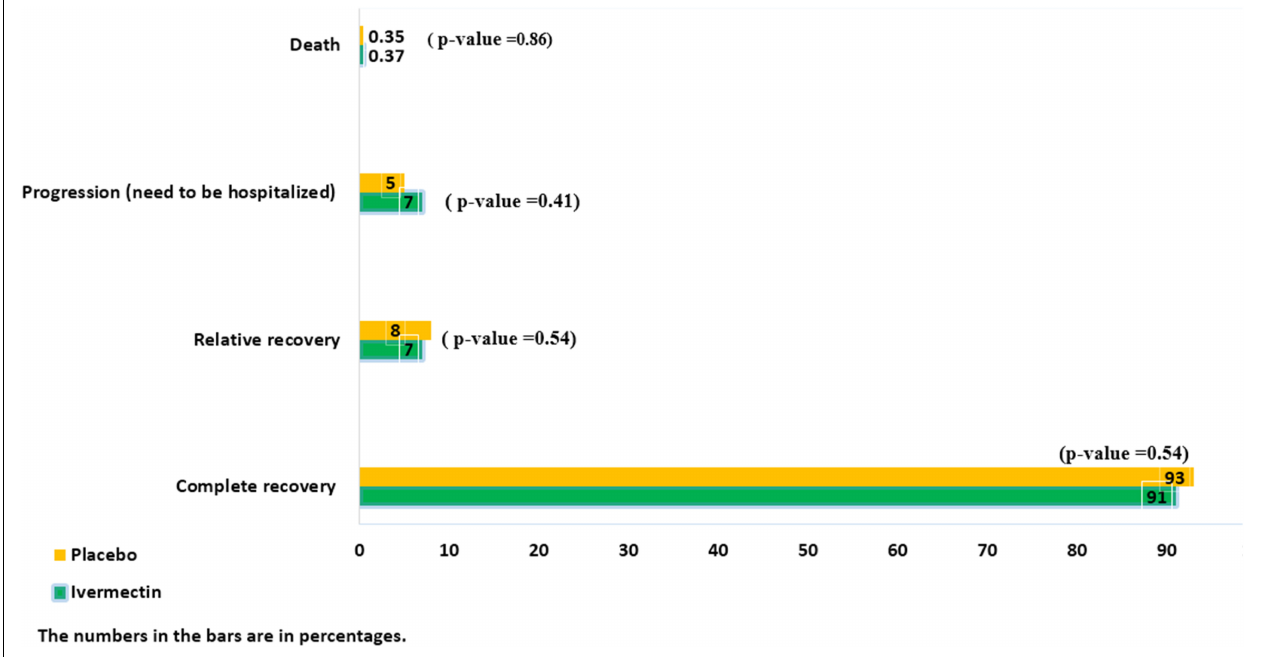
FIGURE 4 | The main outcomes in outpatients with COVID-19.